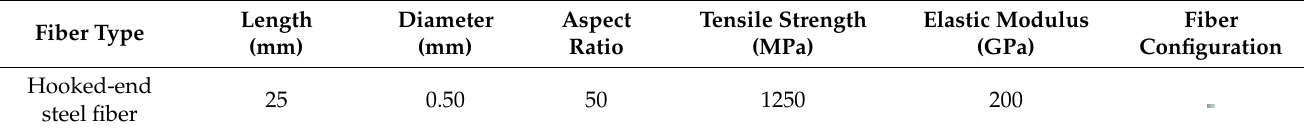
Table 2. Properties and configuration of hooked-end steel